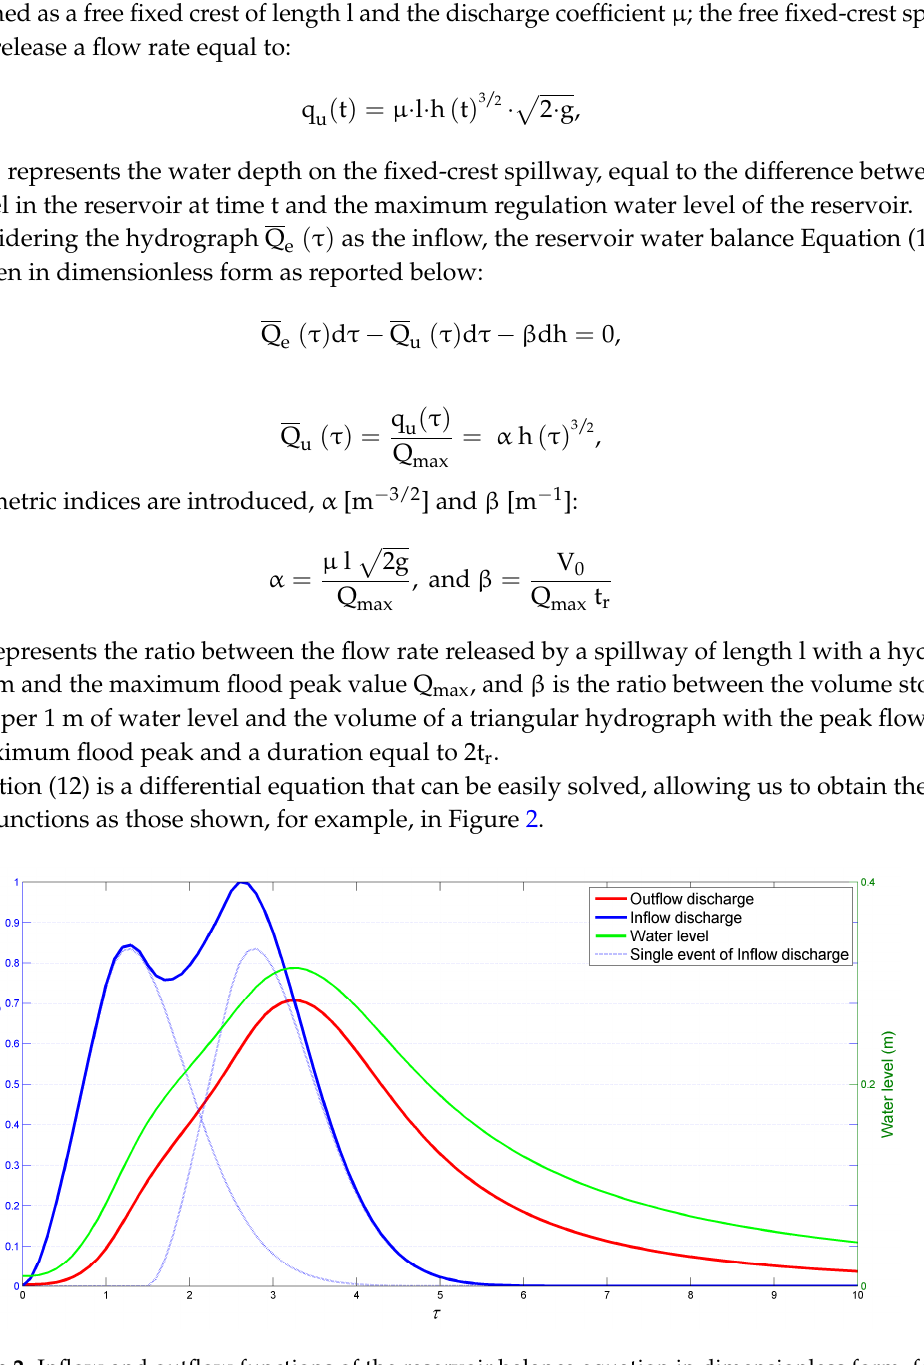
Figure 2. Inflow and outflow functions of the reservoir balance equation in dimensionless form, for DC α = 4, SC β = 4 and time shift between the two peaks Δ = 1.5. In blue is reported the inflow dimensionless total discharge, in red the outflow discharge from the dam, in green the water level in the reservoir.